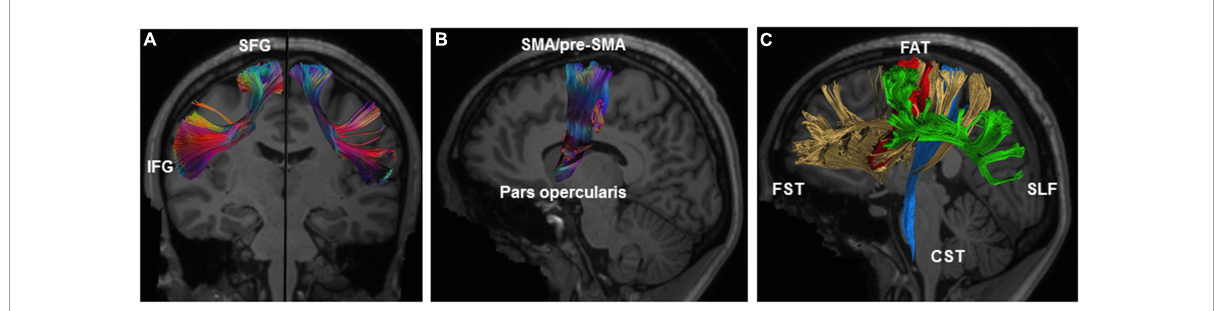
FIGURE2 Illustration of the anatomy of the right FAT. (A) Coronal view of the left and right FAT with description of connected gyri. (B) Sagittal view of the right FAT showing connected brain areas. (C) Relationship of FAT (red) to the surrounding white-matter tracts including the SLF (green), FST (yellow), and CST (blue). CST, corticospinal tract; FAT, frontal aslant tract; FST, frontostriatal tract; IFG, inferior frontal gyrus; SFG, superior frontal gyrus; SLF, superior longitudinal fasciculus. Illustration of the frontal aslant tracts based on data freely available from the Human Connectome project and constructed with DSI studio software (https://db.humanconnectome.org; http://dsi-studio.labsolver.org).